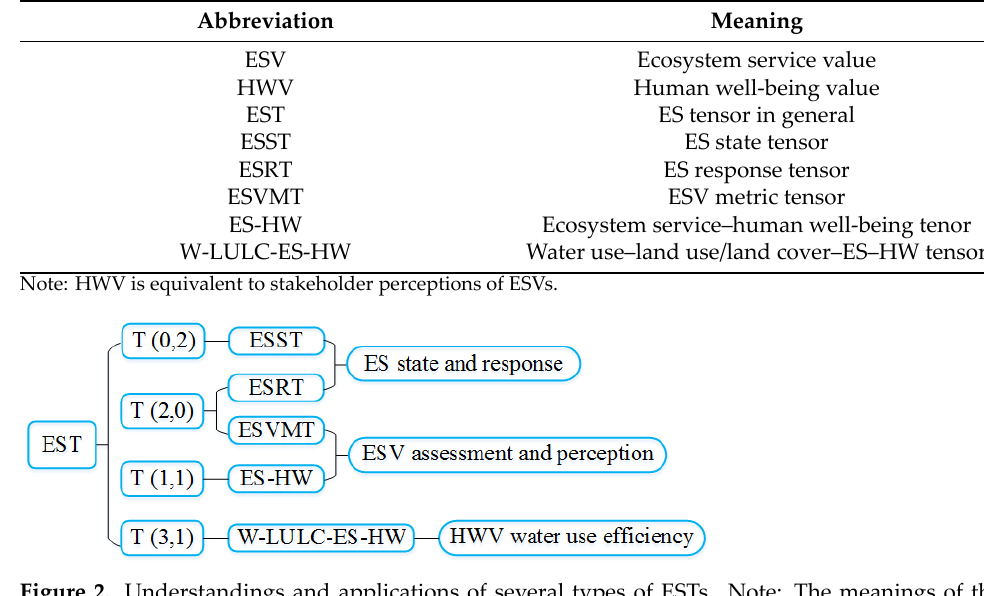
Figure 2. Understandings and applications of several types of ESTs. Note: The meanings of the abbreviations are listed in Table 1 below. Table 1. The meaning of abbreviations in this article.